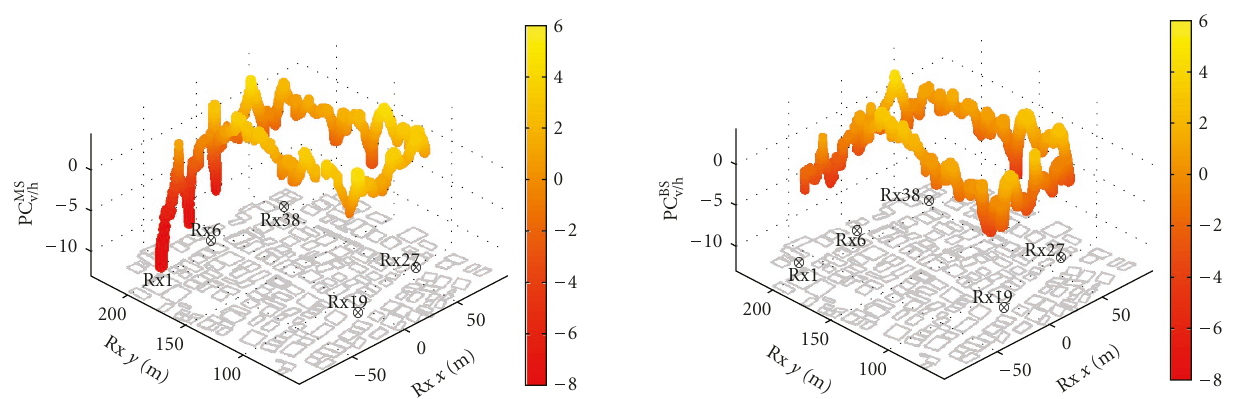
Figure 24: XPRC MS